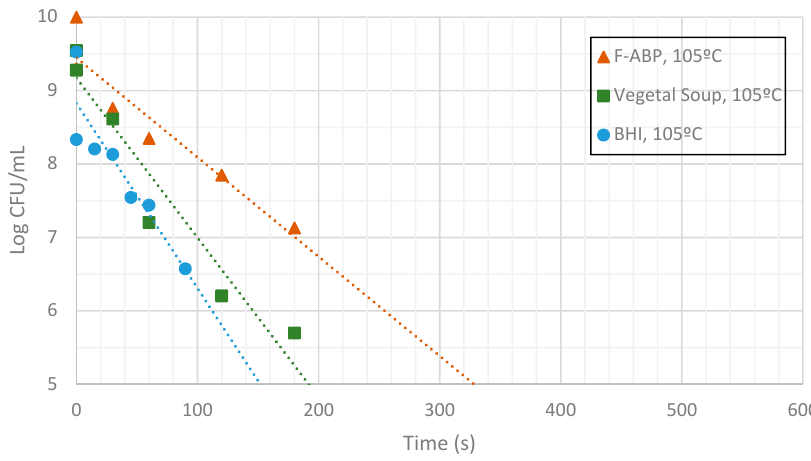
Figure 11. Measurement of CFUs in the substrates indicated at a target temperature of 105 °C. At 105 ◦ C a fast inactivation is observed, with 3 log decimal reductions in less than 120 s in BHI, whereas to achieve the same inactivation in F-ABP more than 200 s are necessary, as Figure 11 shows. Vegetable soup required a time in between. Differences in heat inactivation can be explained by